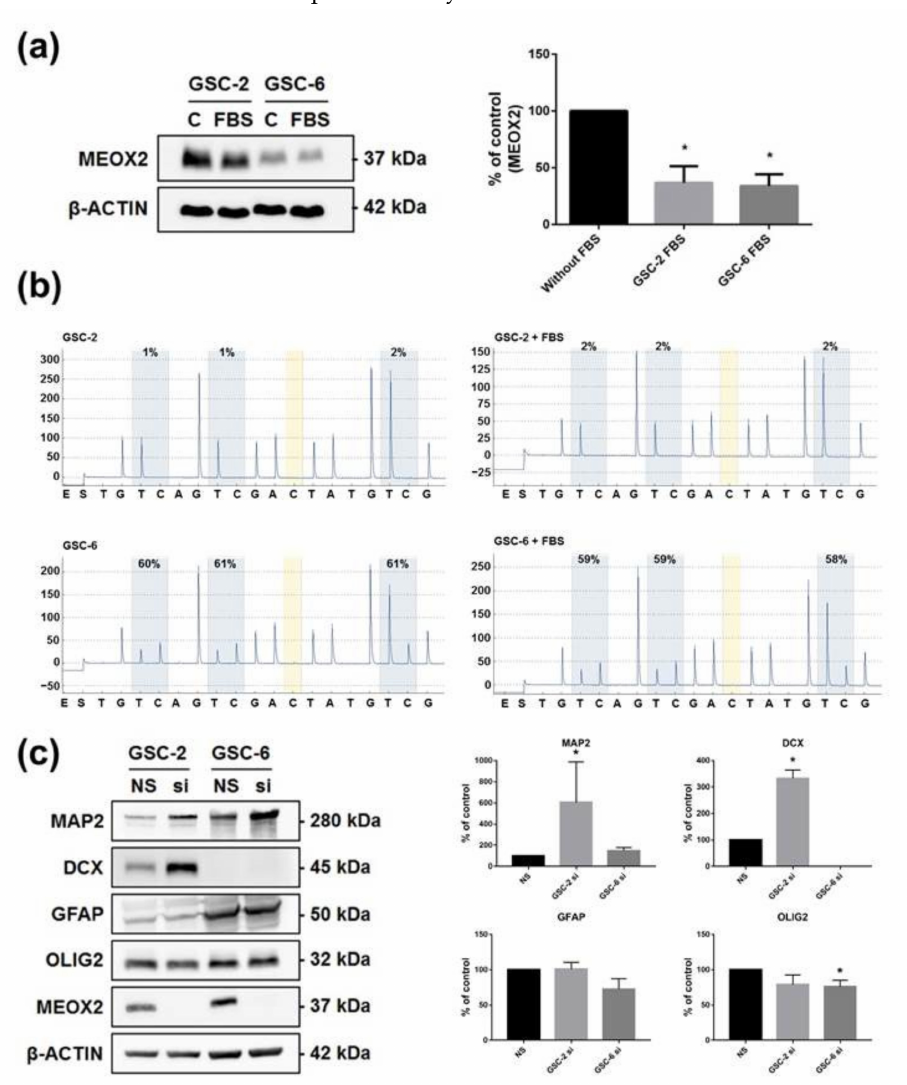
Figure 5. Differentiation of GSC and acquisition of neuronal lineage features after MEOX2 inhibition. ( a ) Representative WB and histograms of MEOX2 expression after 6 days of culture in 5% Fetal Bovine Serum (FBS) ( n = 4, * p < 0.05, Mann–Whitney test); ( b ) methylation profile of GSC-2, -6 lines after 6 days of culture in 5% fetal bovine serum (FBS); ( c ) representative WB and histograms for MAP2, DCX, GFAP, and OLIG2 expression after inhibition of MEOX2 (siRNA1) for 6 days in GSC-2 and GSC-6 ( n = 4, * p < 0.05, Mann–Whitney